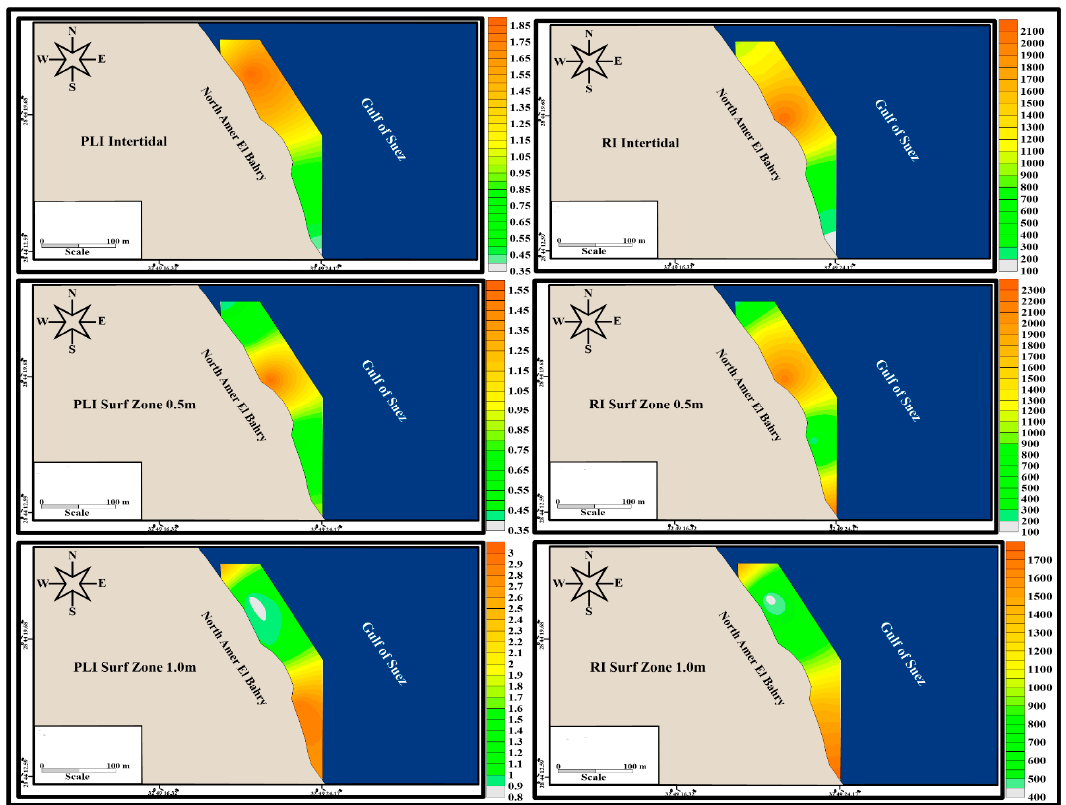
Figure 3. Spatial distribution for the pollution load index (PLI) and the potential ecological risk index (RI) at North Amer El ‐ Bahry.